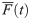
Comparison of the association kinetic traces.(A) Fluorescence, F¯(t), anisotropy, r¯(t) and corrected fluorescence anisotropy, rF¯(t) reaction traces of BcO (20 nM) binding to SAV (200 nM) at 10°C. The mono-exponential fits (black) resulted in kon values of 1.73 × 107 M-1s-1, 1.72 × 107 M-1s-1 and 1.04 × 107 M-1s-1 with halftimes of 200.6 ms, 201.4 ms and 332.7 ms, respectively. The respective residual of the reaction traces versus fit curves show that (B)
rF¯(t) and (C)
F¯(t) were optimal, and (D)
r¯(t) signal is ill-fitted. The kon of r¯(t) was 40% slower than the other two and showed the worst residuals due to changes in QY [55]. The corresponding normalization signals are: rF¯(t)=[rF(0)−rF(t)]/[rF(0)−rF(∞)],F¯(t)=F(t)F(0)=[F(t)−rF(∞)]/[rF(0)−rF(∞)] and r¯(t)=[r(0)−r(t)]/[r(0)−r(∞)].